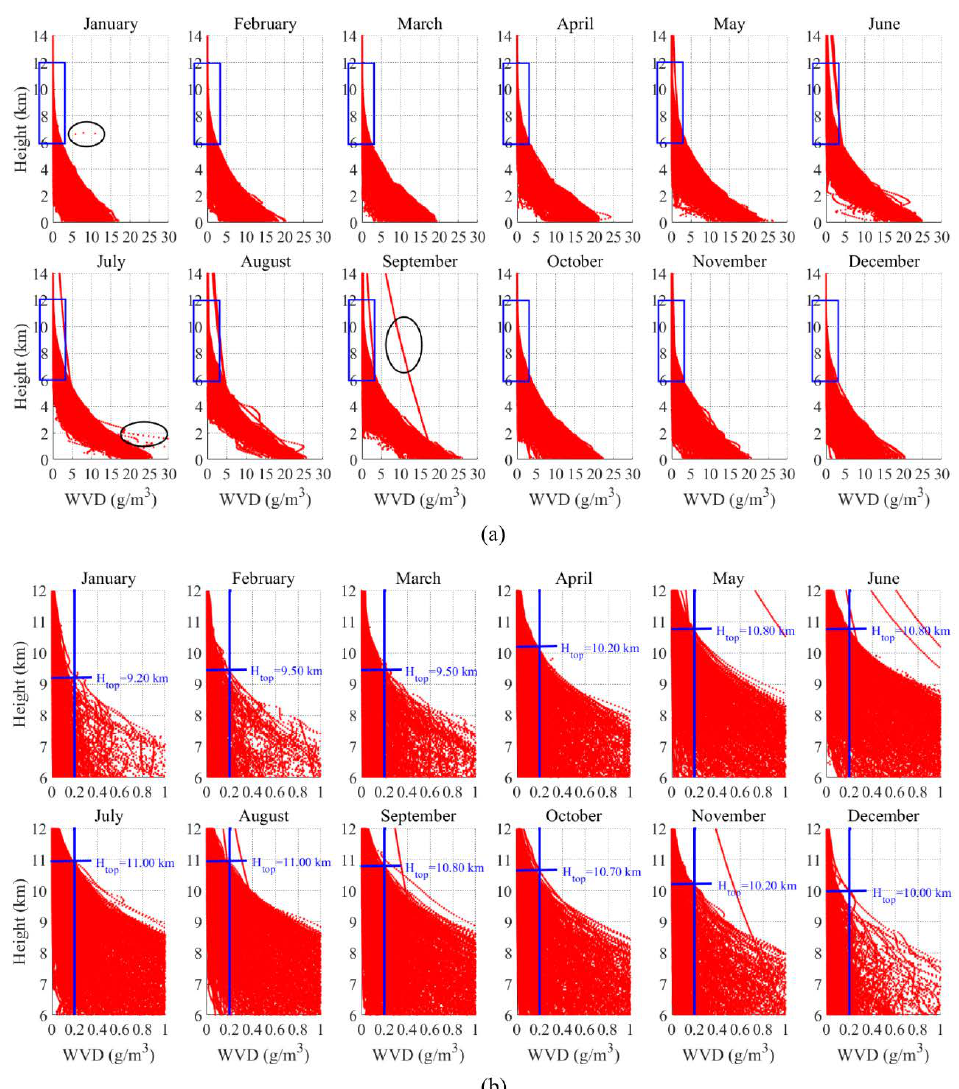
Figure 1. The distribution of water vapor derived from 30 years of radiosonde data in the atmosphere for di ff erent months. ( a ) The vertical distribution of atmospheric water vapor. The black ellipse in ( a ) represents the outliers; ( b ) enlarged view corresponding to the blue rectangle in ( a ). Blue vertical lines in ( b ) correspond to the principle that the water vapor density (WVD) is 0.2 g / m 3 , and the blue horizontal lines denote the optimal top boundary during di ff erent